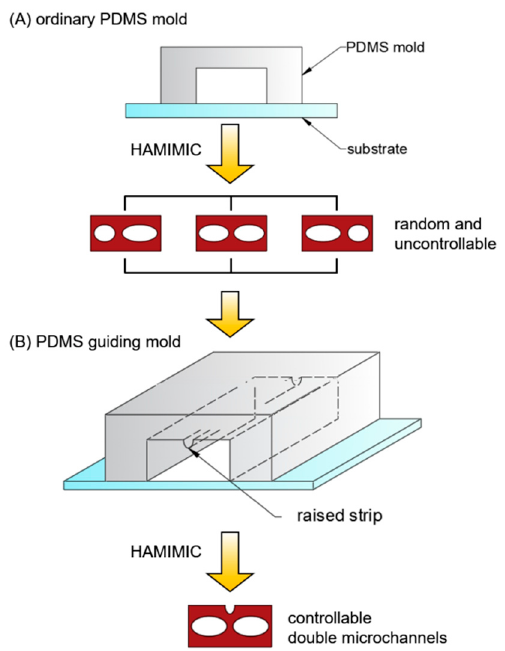
Figure 5. Schematic illustration of fabricating two parallel microchannels with ordinary PDMS mold ( A ) and PDMS guiding mold ( B ).